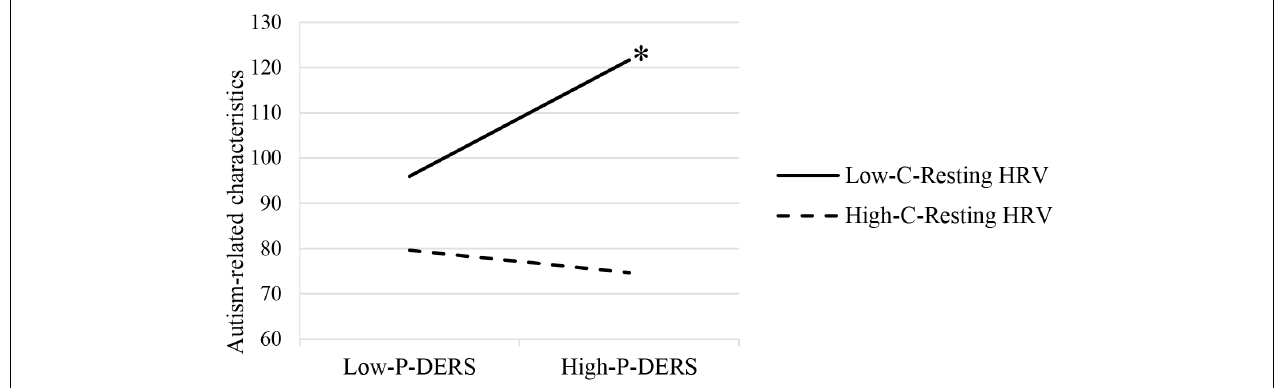
FIGURE 1 | Moderating effects of child resting HRV on the relationship between parental emotion dysregulation and ASD child autism-related characteristics. P-DERS, Parental emotion dysregulation; C-Resting HRV, Child resting heart rate variability. ∗ p <